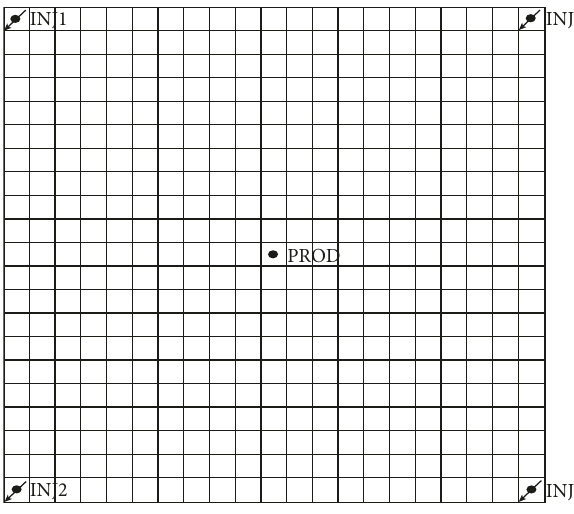
Figure 6: Grid subdivision schemes of the model.